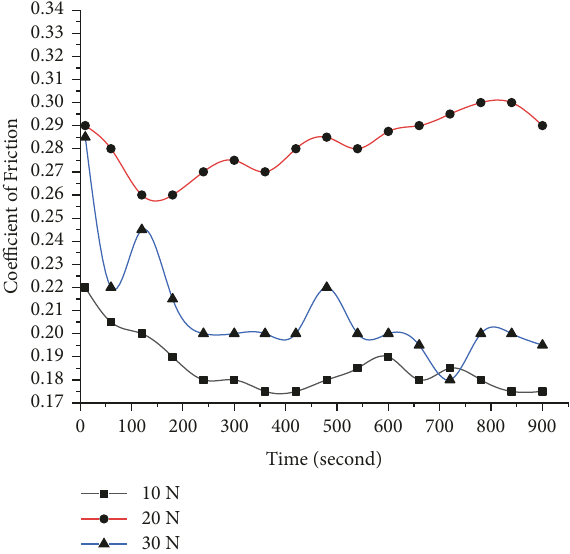
Figure 10: Wear varying with contact time at various loads and % reinforcements.